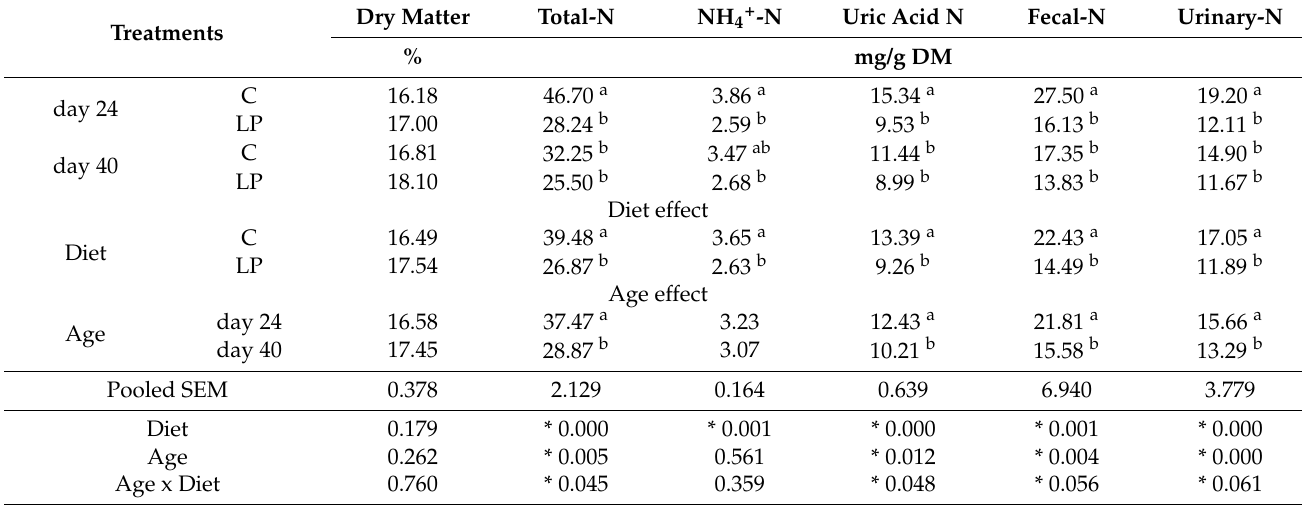
Table 4. The amount of the total-N, NH 4+ -N, uric acid-N, and dry matter content of the excreta.